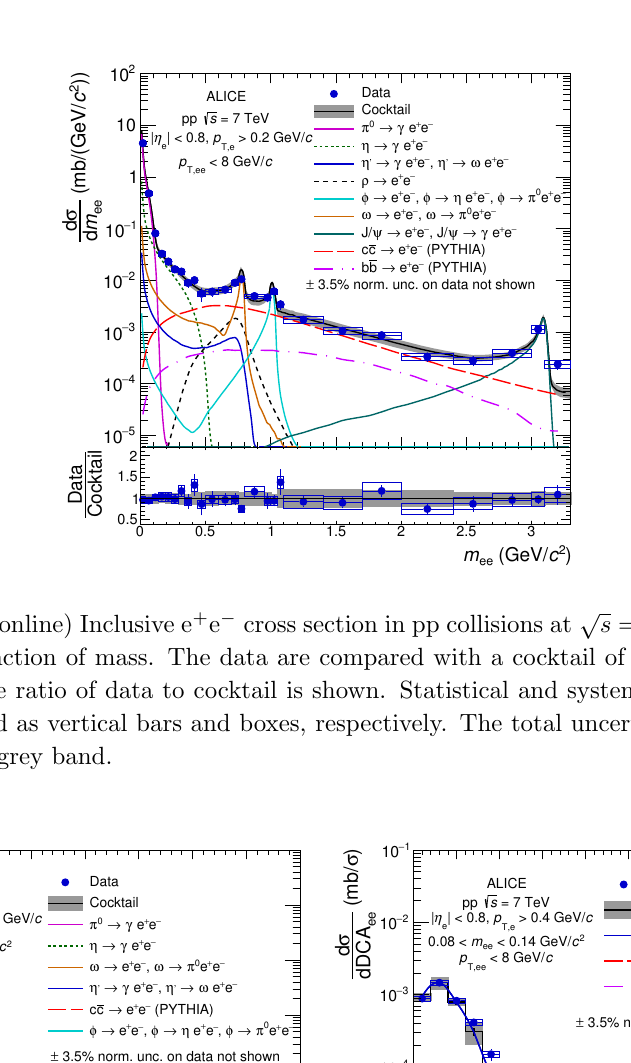
Figure 10 . (Colour online) Inclusive e + e (cid:0) cross section in pp collisions at ALICE acceptance as a function of p T ; ee (left) and DCA ee (right) for m ee < 0.14 GeV/ c 2 and 0.08 < m ee < 0.14 GeV/ c 2 , respectively. sources. In the bottom panels, the ratio of data to cocktail as a function of p T ; ee (left) and the pull distribution as a function of DCA ee (right) are shown. Statistical and systematic uncertainties on the data are plotted as vertical bars and boxes, respectively. The total uncertainty of the cocktail is represented as a grey band.